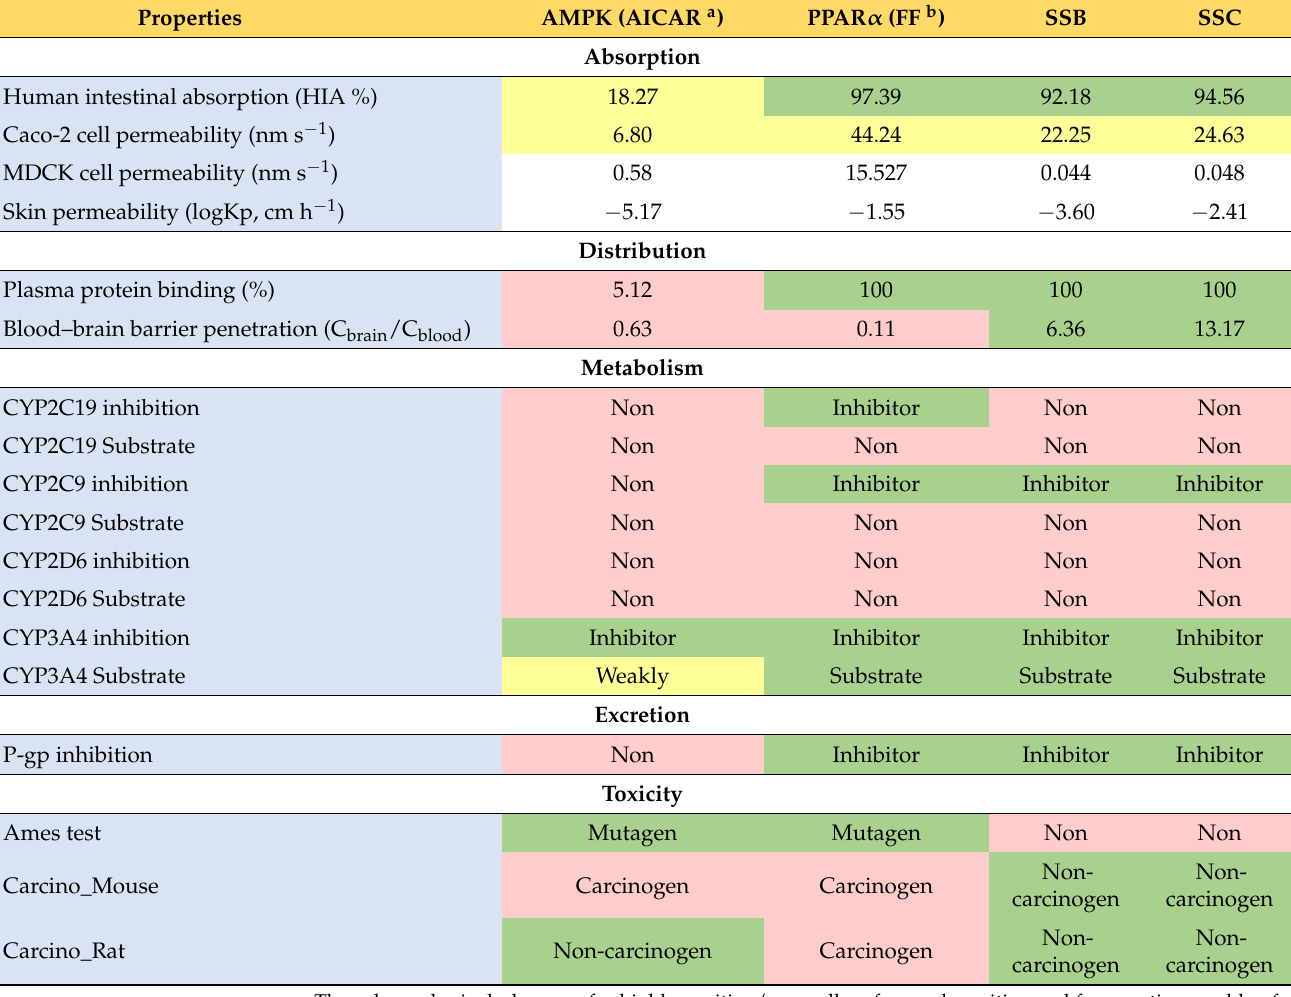
Table 1. Detailed comparison of ADMET properties between control compounds of AMPK (AICAR) and PPAR α (Fenofibrate) with soyasapogenol B and soyasapogenol C using the online tool